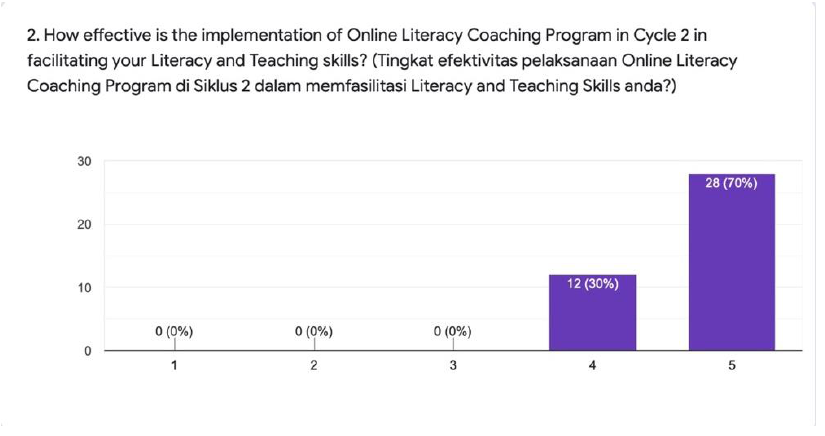
Figure 5: The Result of the Close-ended